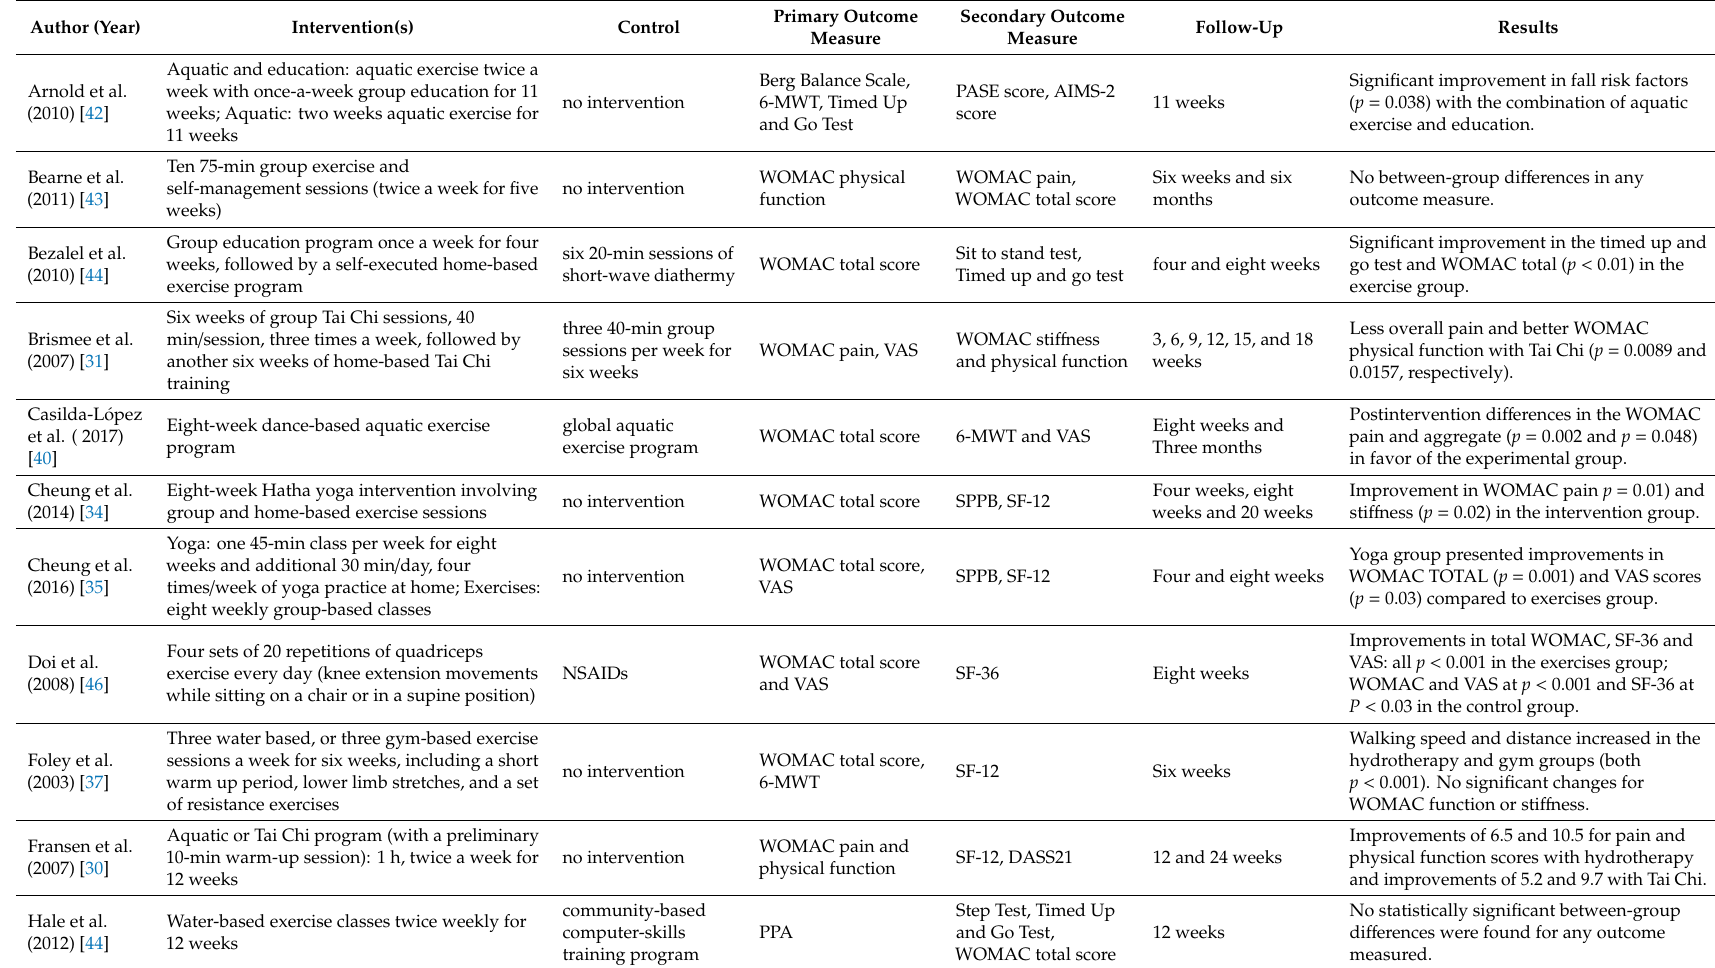
Table 2. Clinical outcome data of the included